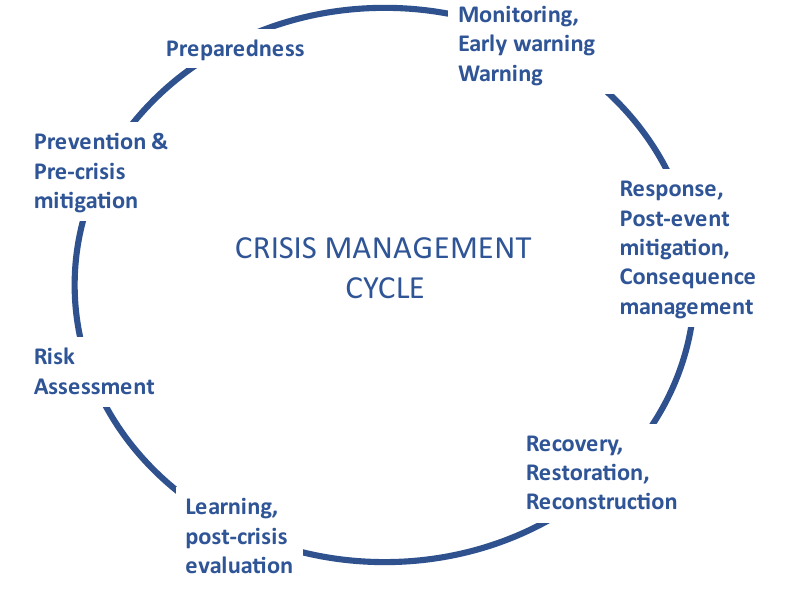
Figure 3. The stages of a crisis management cycle [71].